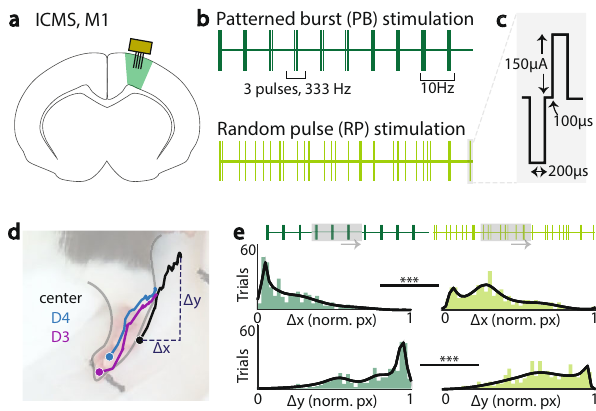
Fig. 6 The role stimulation variability in driving variability of upper-limb movements. a Location of stimulation, via microwire array to M1 for identi fi cation of regions eliciting forelimb movement. b Patterns of stimulation delivery, with balance of total charge delivered. Patterned burst stimulation (top, PB) consisted of 333 Hz triplets, at 10 Hz triplet frequency. Random pulse stimulation (bottom, RP) consisted of single pulses, randomly timed at 30 Hz. Stimulation was delivered for 1 s per session, for a total of 30 pulses per session. c Stimulation pulse parameters, with 200 μ A biphasic pulse, 200 μ s per phase with 100 μ s inter-phase interval. d Lateral view of paw: limb markers labeled for supervised kinematic tracking: tip of digit 4 (D4, blue), tip of digit 3 (D3, purple), and center of paw (center, black). Endpoint location of each trial ( Δ x, Δ y) was calculated relative to start location in trial window and normalized by animal across stimulation conditions. e Example animal histograms of normalized Δ x (top) and Δ y (bottom) for center of paw across patterned burst stimulation trials (left) and random pulse stimulation trials (right). Gray boxes show an example 300 ms window with identical number of pulses. Kolmogorov-Smirnov test for two samples in this example animal, center of paw, p = 1.8e − 11; *<0.05; **<0.01; ***<0.001, Kolmogorov-Smirnov test for two samples. Source data are provided as a Source Data fi